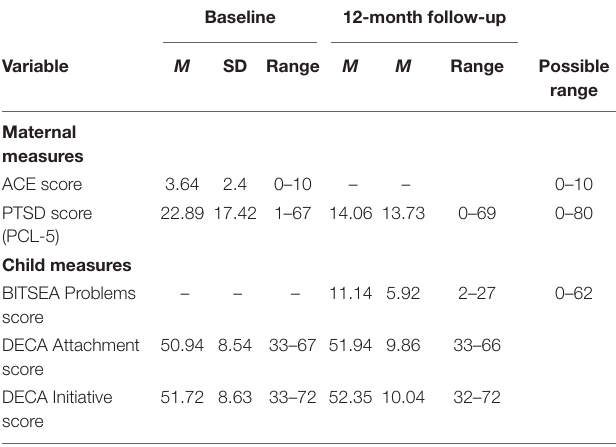
TABLE 2 | Descriptive statistics for key study